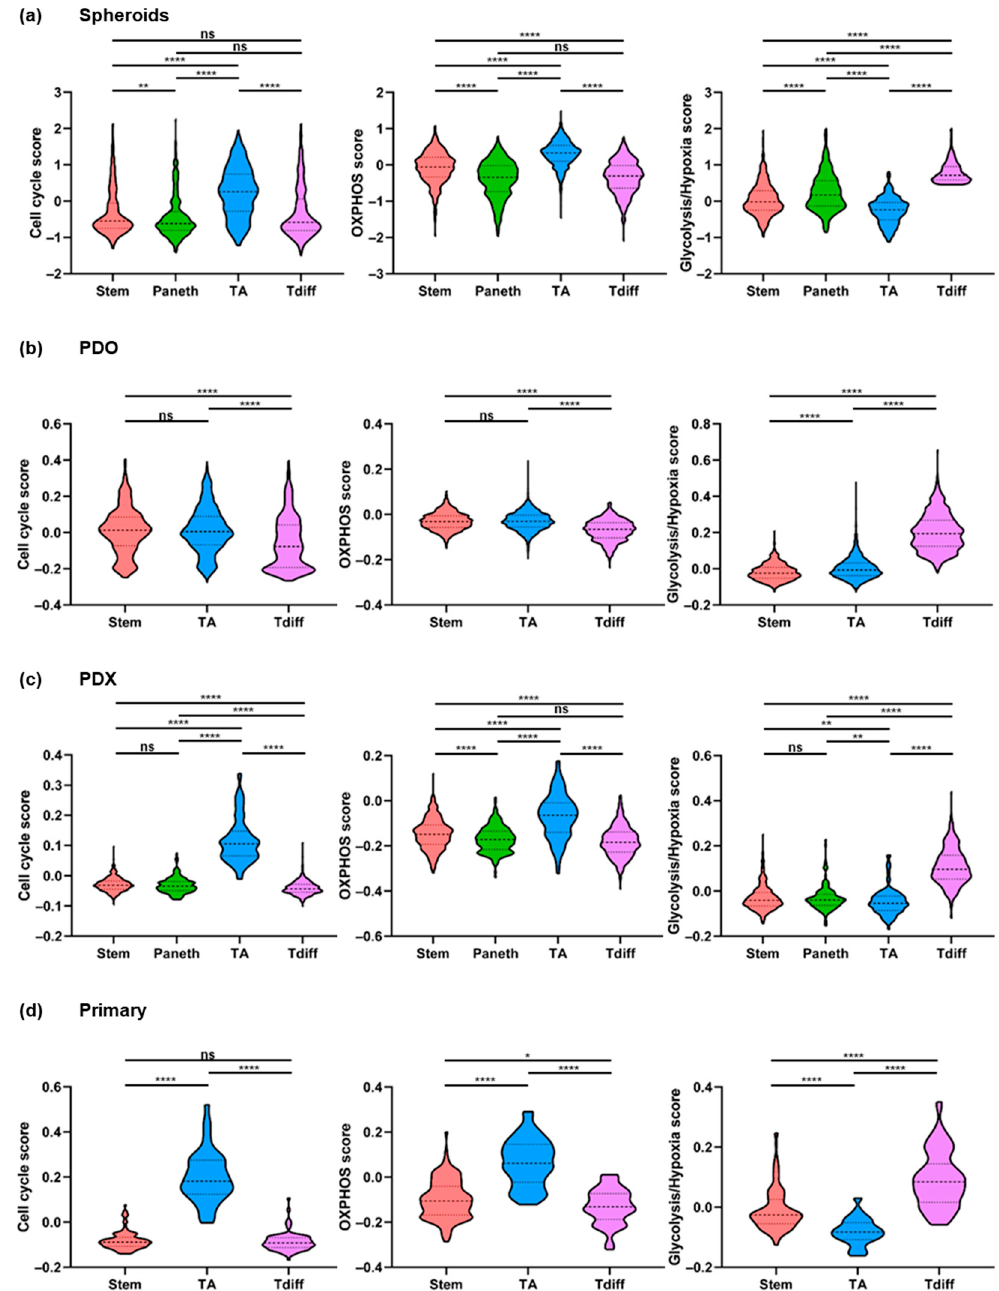
Figure 3. Cell state scores for cell type-specific cell subsets inferred by non-negative matrix factorization. ( a – d ) Cell cycle, oxidative phosphorylation (OXPHOS), and glycolysis/hypoxia scores (signatures G2/M, OXPHOS_2, and Hypoxia/Glycolysis_2, respectively) for cells of ( a ) spheroids ( n = 8 LGR5 + cultures), ( b ) patient-derived organoid (PDO; O1), ( c ) patient-derived xenograft (PDX; X1), and ( d ) merged tumor epithelial cells (T1–T3) classified under active cell type-specific meta-signatures: stem-like (spheroids: n = 467; PDO: n = 944; PDX: n = 667; primary: n = 124), Paneth-like (spheroids: n = 357; PDX: n = 189), transit-amplifying (TA)-like (spheroids: n = 554; PDO: n = 3,967; PDX: n = 100; primary: n = 49), terminally differentiated (Tdiff)-like cells (spheroids: n = 486; PDO: n = 639; PDX: n = 424; primary: n = 80). p -Values were calculated based on the Mann–Whitney Test (two-tailed). * p < 0.05; ** p < 0.01; **** p < 0.0001; ns, not significant. Dashed lines indicate medians. Upper and lower dotted lines indicate 75% and 25% percentiles,